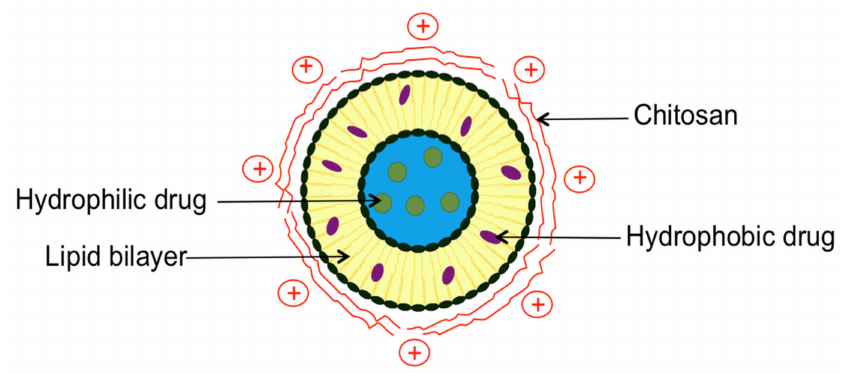
Figure 2. Schematic representation of drug-loaded